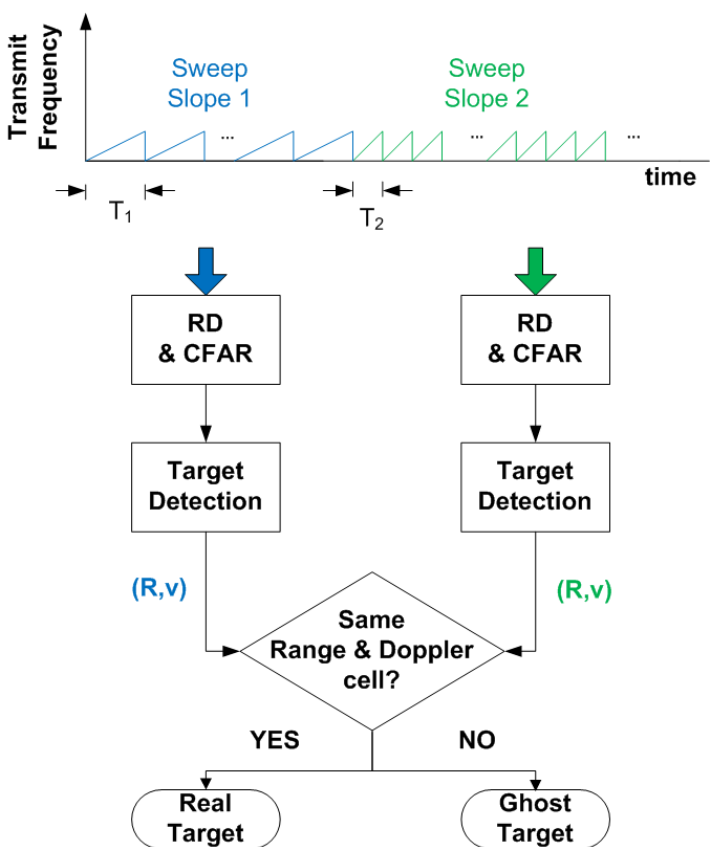
Figure 23. Procedure used to detect a spoofing target using data from two chirps with different sweep slopes.